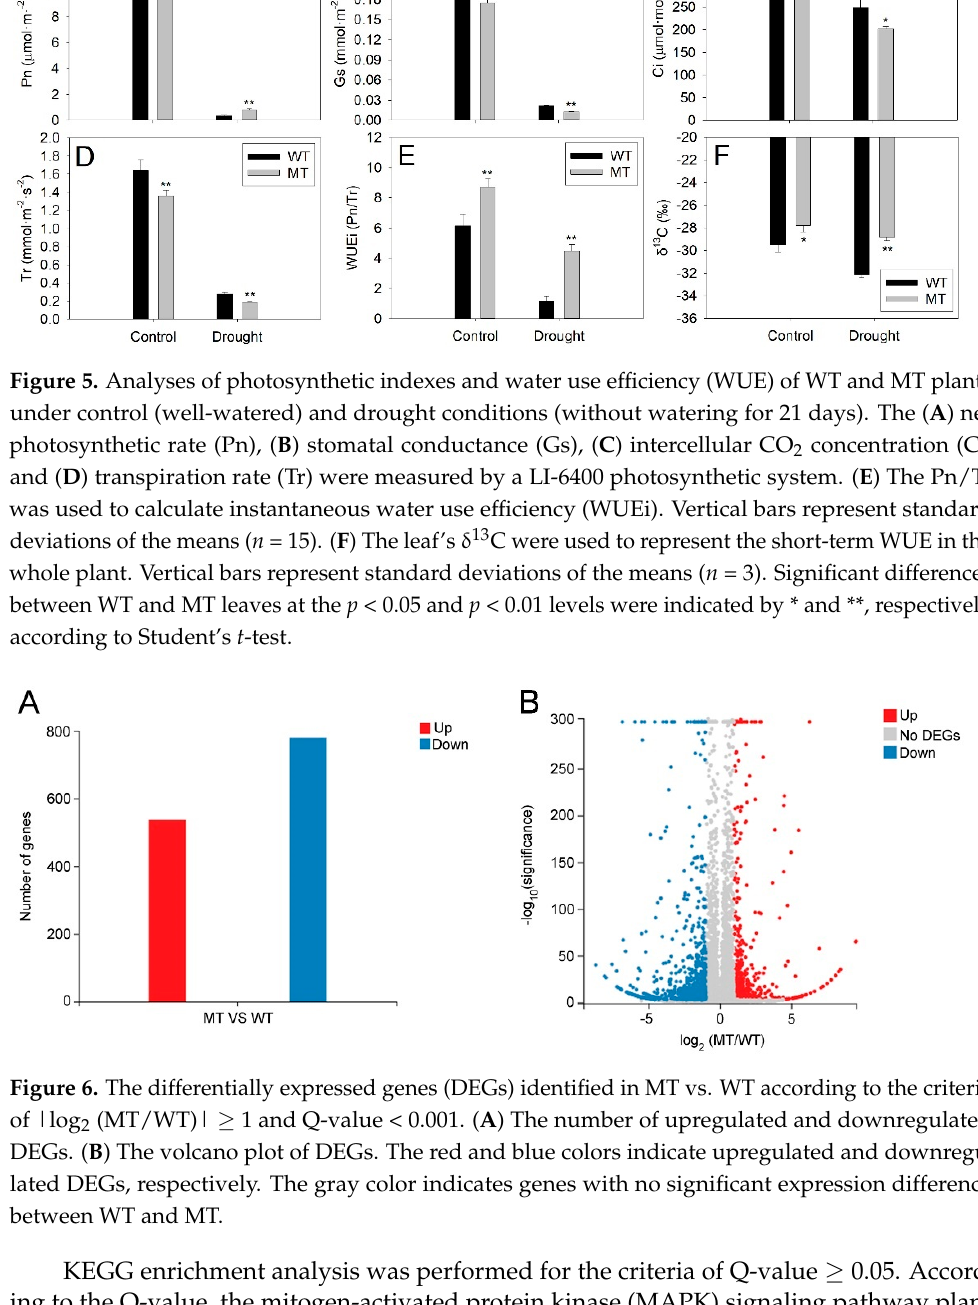
Figure 6. The differentially expressed genes (DEGs) identified in MT vs. WT according to the criteria of |log 2 (MT/WT)| ≥ 1 and Q-value < 0.001. ( A ) The number of upregulated and downregulated DEGs. ( B ) The volcano plot of DEGs. The red and blue colors indicate upregulated and downregu- lated DEGs, respectively. The gray color indicates genes with no significant expression difference between WT and MT.